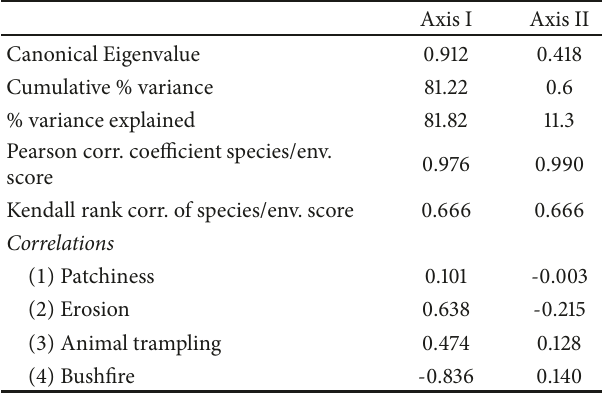
Table 3: Summary of canonical correspondence analysis (CCA) of birds showing the levels of correlation between axes and environ- mental gradients, variance of species, and species-environmental relationships in the dry